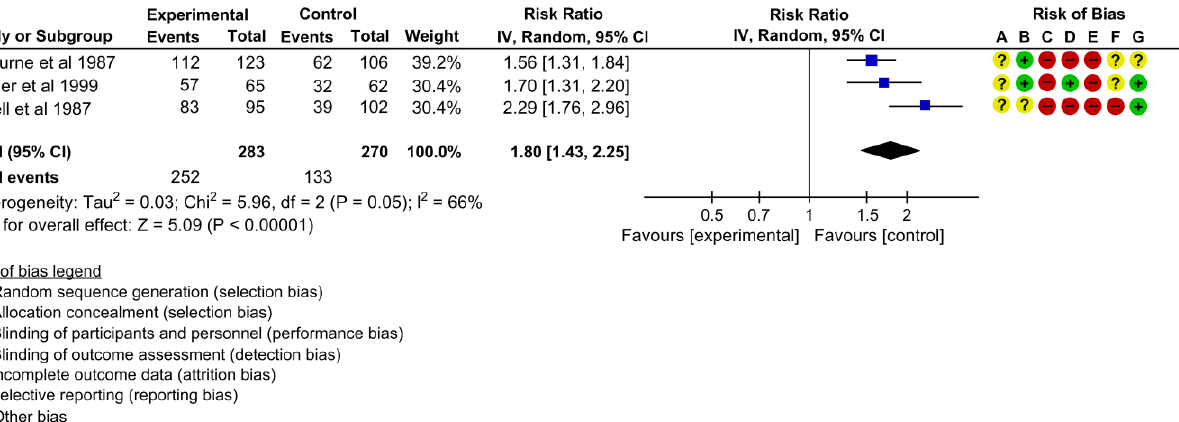
Figure 13. Meta-analysis for the effect of MCH handbook interventions vs. standard care on women who wanted to carry their case notes in subsequent pregnancy [22,24,25]. Red color with a − symbol means a high risk of bias, yellow color with a ? symbol means an unclear risk of bias, and green color with a + symbol means a low risk of